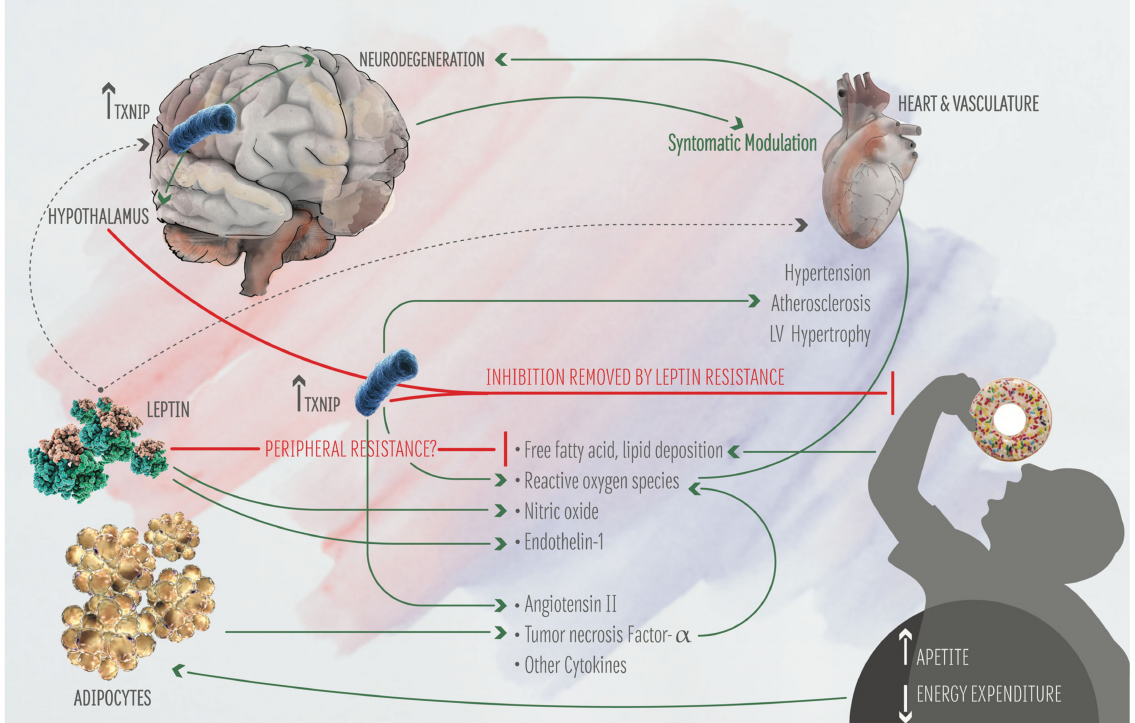
Figure 2. Effect of TXNIP on the brain-heart axis and on human metabolism. Food intake increases TXNIP expression in Agrp neurons of the hypothalamus, inducing satiety. Enhanced expression of TXNIP in the hippocampus leads to neuronal dysfunction. Hyperglycemia and diabetes induce elevated TXNIP expression in several tissues, leading to hypertension, atherosclerosis, and enhanced production of reactive oxygen species (ROS). In turn, ROS participate to neurodegeneration. It is also shown the effect of Leptin on the metabolism and the brain-heart